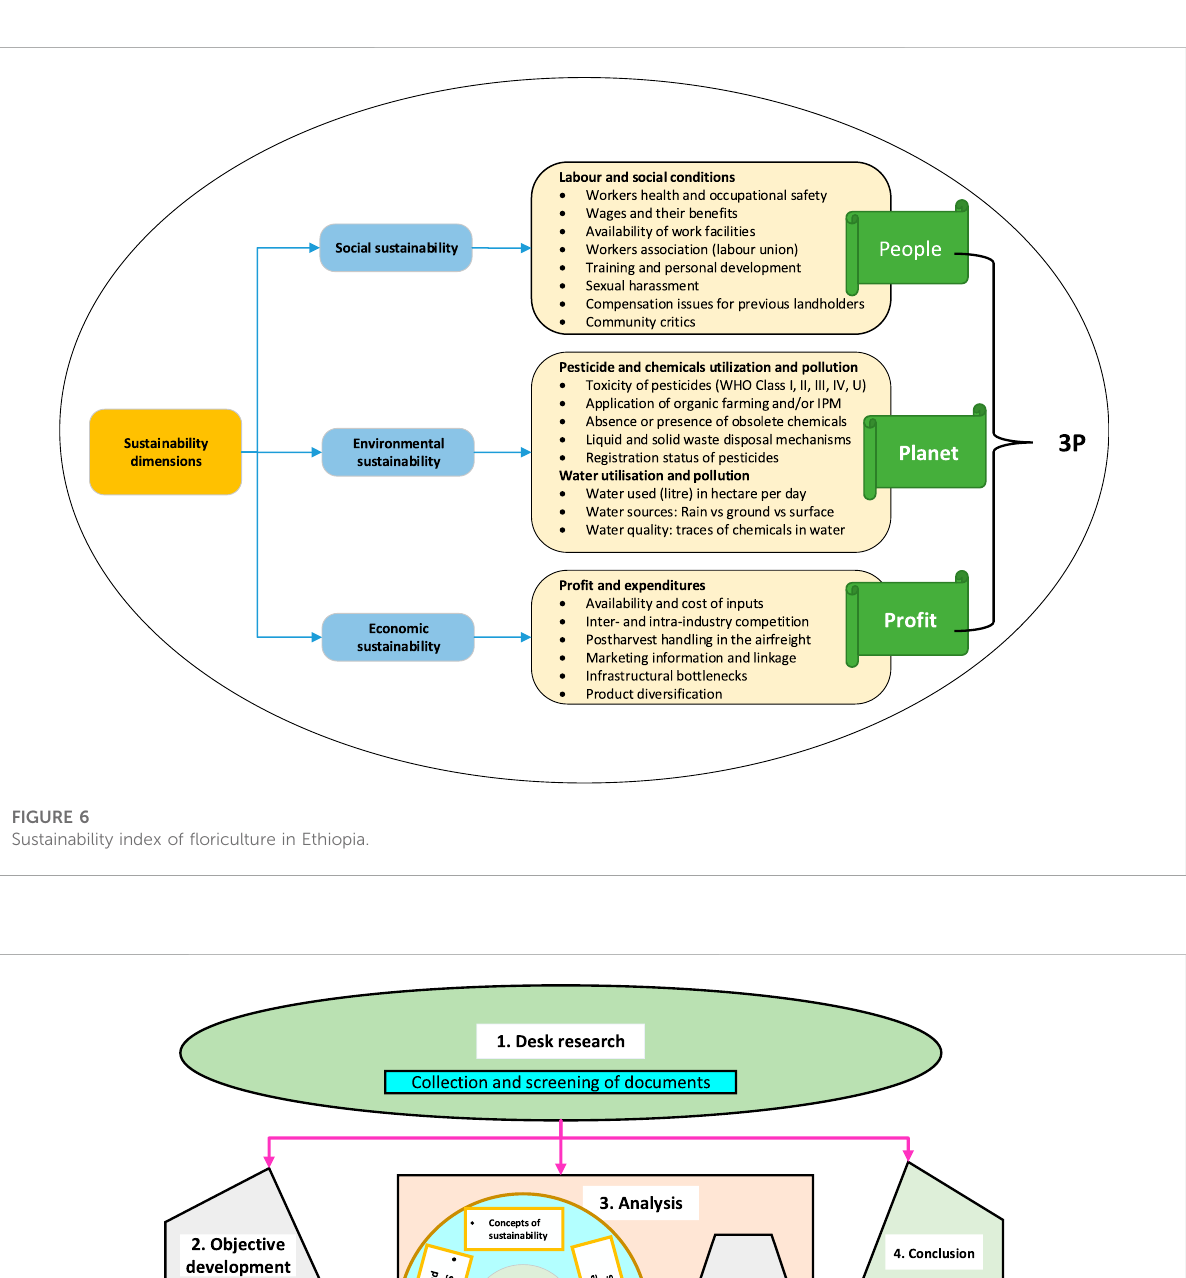
FIGURE 7 Methodology of the desk